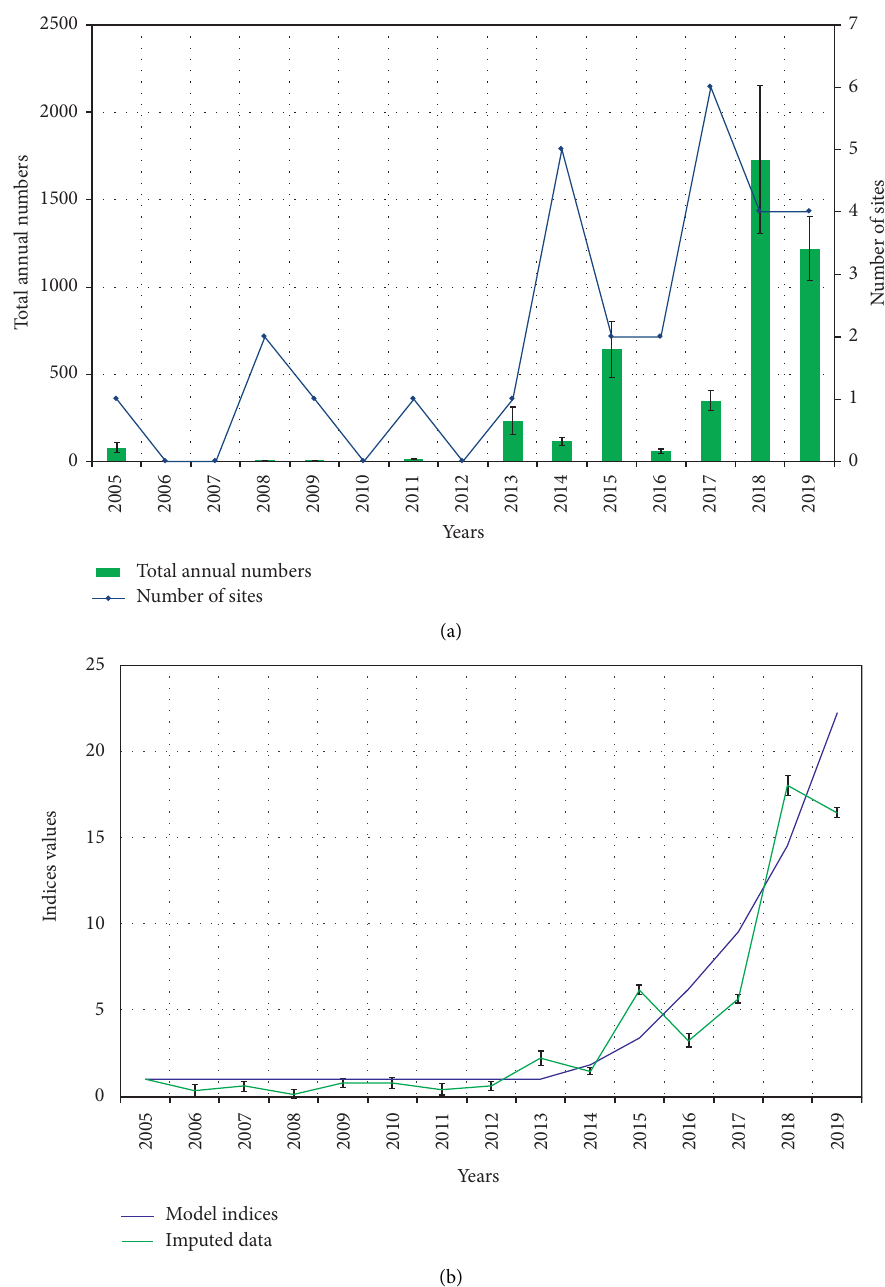
Figure 3: (a) Total annual numbers of the White-headed Duck and the number of wetlands where it has been observed in Morocco between 2005 and 2019. (b) Linear trend of the wintering population (TRIM